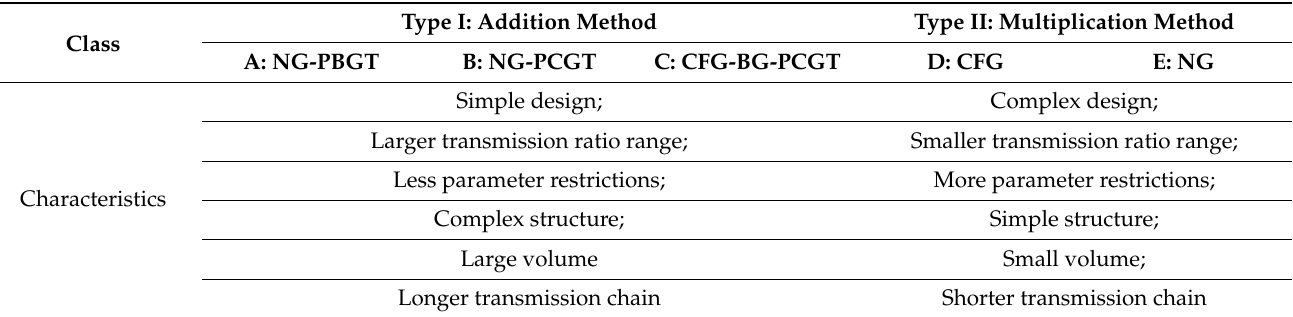
Table 5. CVT mechanism characteristics of types I and II.